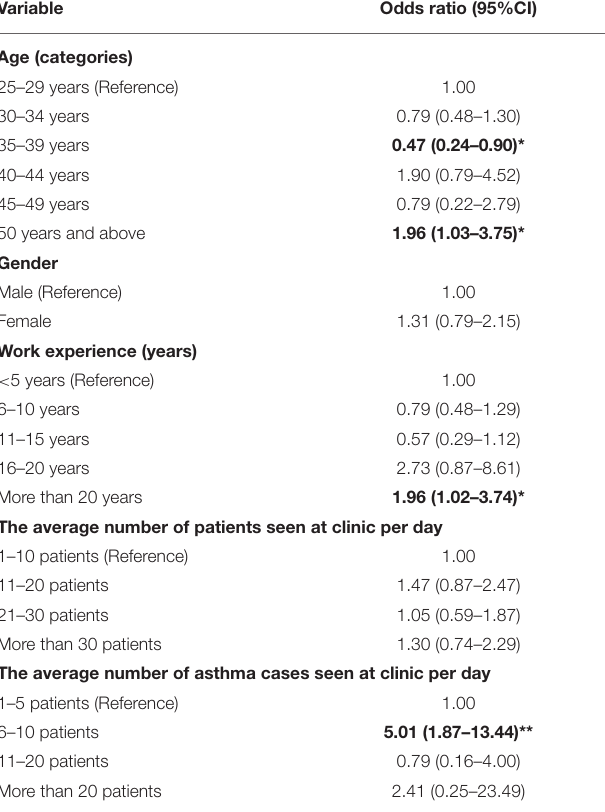
TABLE 4 | Logistic regression analysis (univariate analysis) to identify factors affecting asthma practices.